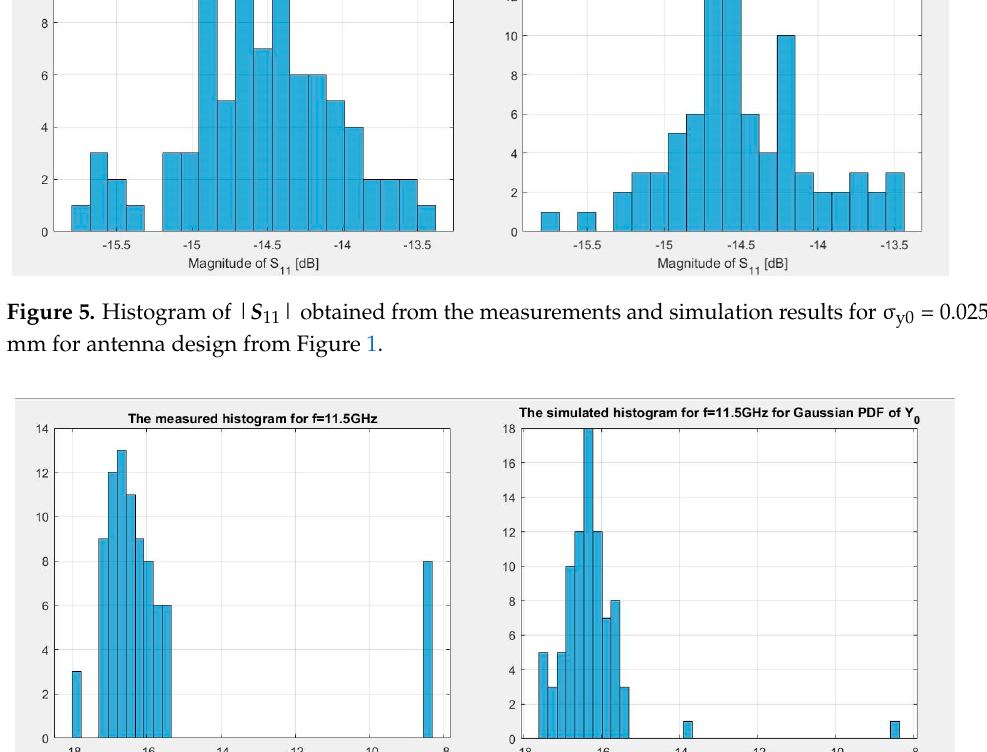
Figure 8. Histogram of | S 11 | obtained from the simulation results for y 0 having Uniform and Beta distribution with the shape parameters α = β = 6 for antenna design from Figure 1. Figure 9. Histogram of | S 11 | obtained from the simulation results for y 0 having a Beta distribution with the shape parameters α = 4, β = 6 and α = 6, β = 4 for antenna design from Figure 1. The estimated geometrical uncertainty of the manufacturing process is used in the next section of the paper. 3. Computation of Data for ANN Training and Testing This section presents an application of the author’s method from [15] to the FDTD- PCE computations of data for training and testing of ANNs that are used to model the stochastic behavior of | S 11 | of an ordinary patch antenna. The following notation is used in the paper. Random variables are denoted with bold font, vectors with capital letters,